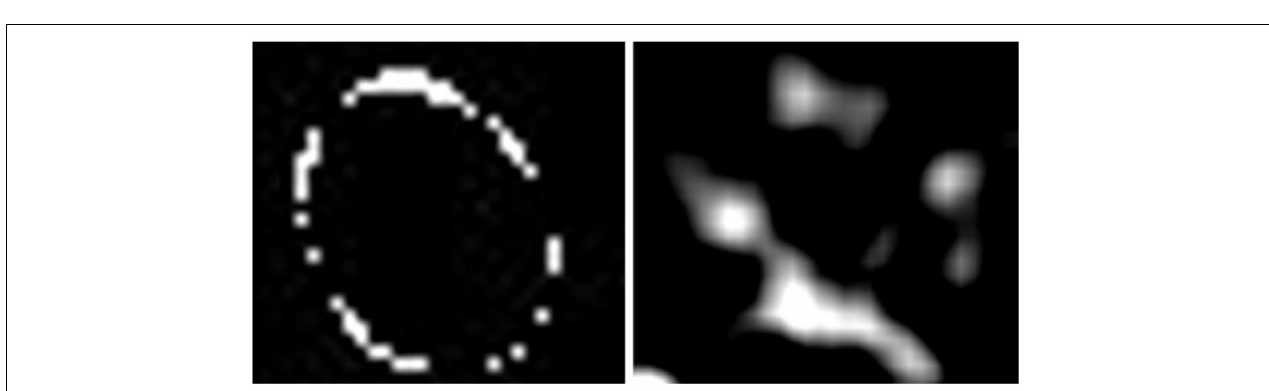
FIGURE 13 | Comparison of gated reconstruction proposed in this work with conventional 4D spatiotemporal reconstruction without gating. Ground truth image (A) and the corresponding reconstructed images with the method proposed in this work with only 18 views per rotation (B) and with the conventional method with 120 views per rotation for the same data set (C) without gating.